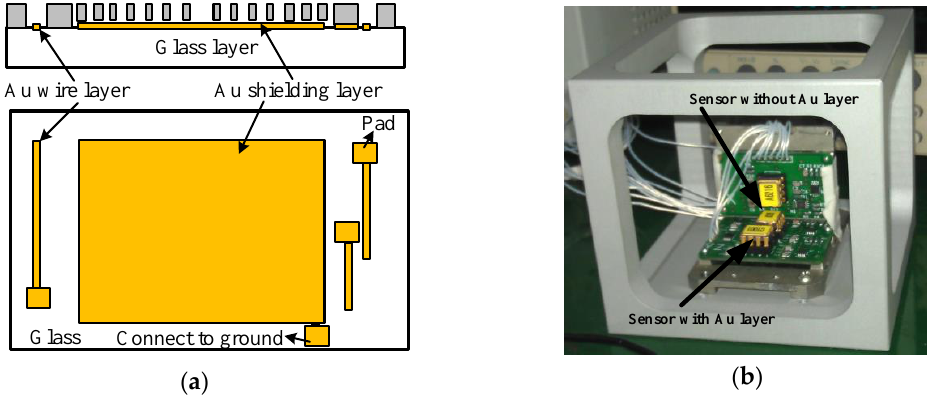
Figure 6. Shielding layer and test platform: ( a ) layout of shielding layer; and ( b ) sensors on platform.